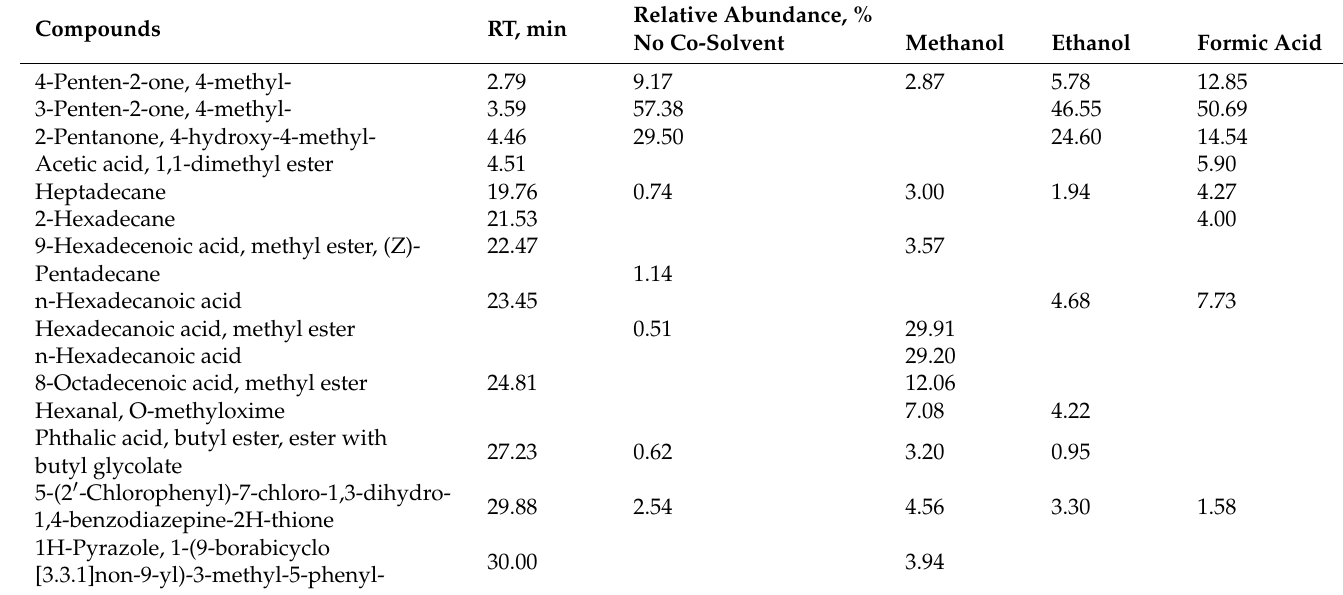
Table 3. GC-MS identification of compounds in biocrude obtained from different co-solvent HTL experiments and the control HTL